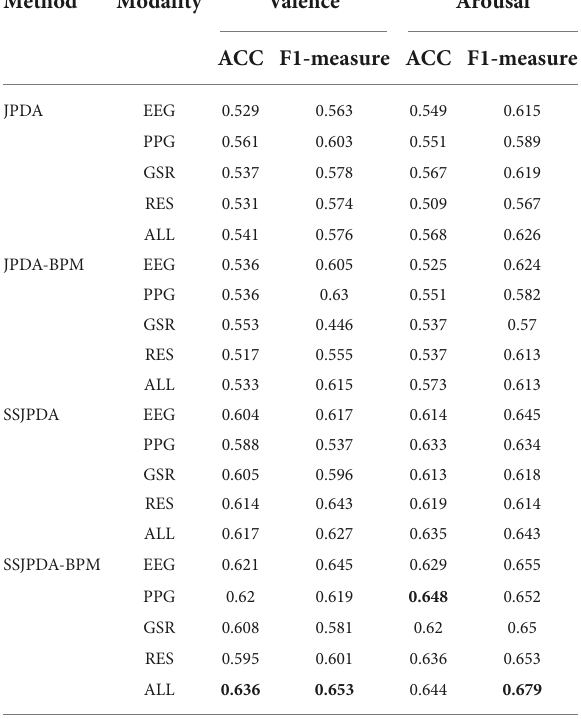
algorithm. The representation generated by SSJPDA-BPM has better separability than others. TABLE 2 The average accuracy (ACC_100%) and F1-measure in different algorithms with single-mode and multi-mode data in valence and arousal